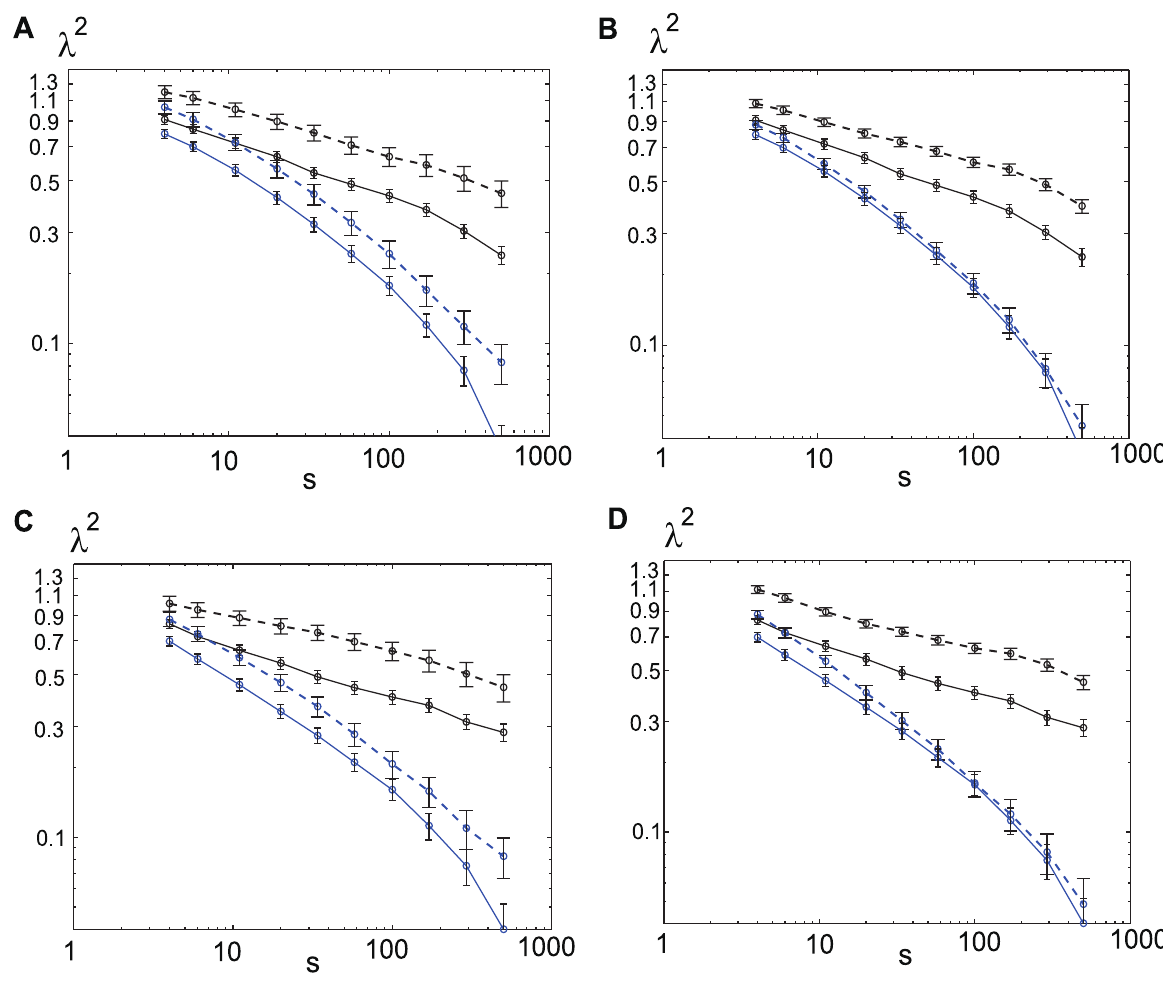
Figure 7. l 2 versus s in log-log coordinates. The scale dependence of l 2 shown in Fig. 6 is replotted in the log-log coordinates.